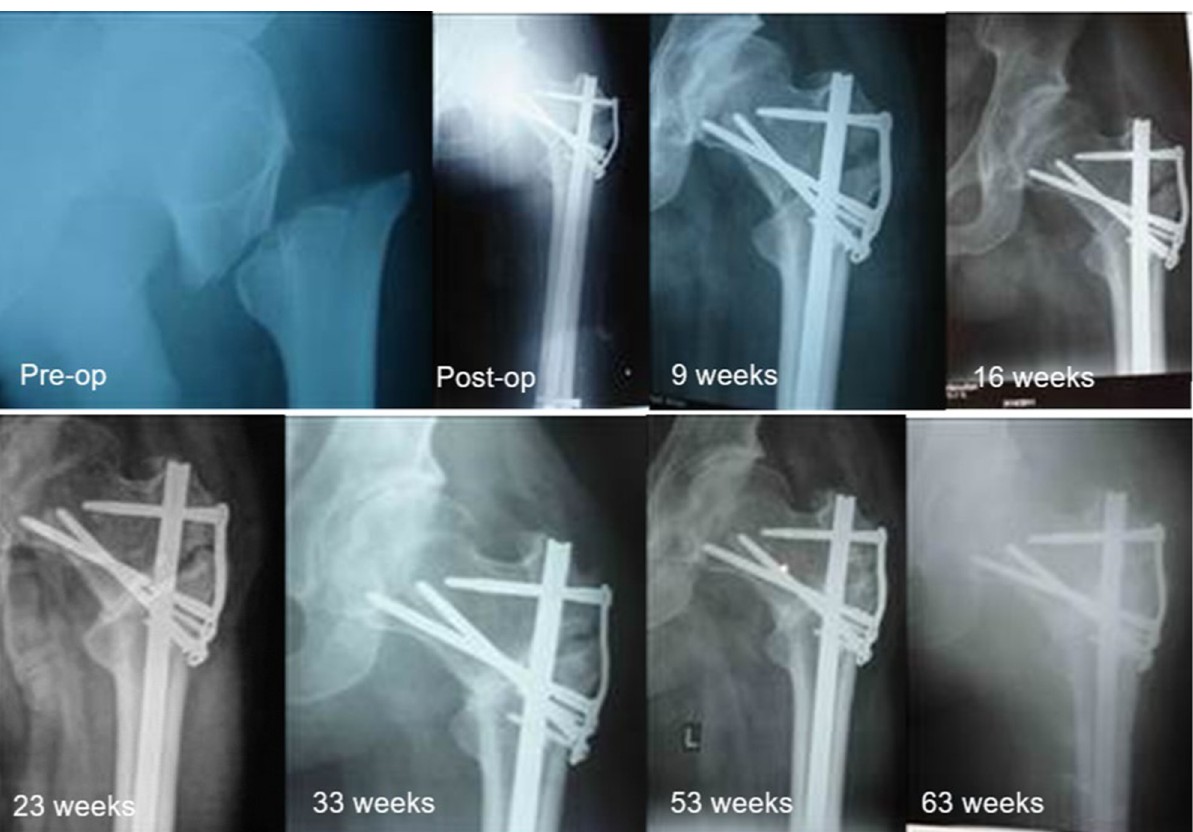
Figure 5. Radiographs of a 30 year old man with delayed union at 33 weeks after surgery but had painless full weight bearing at 9 weeks after